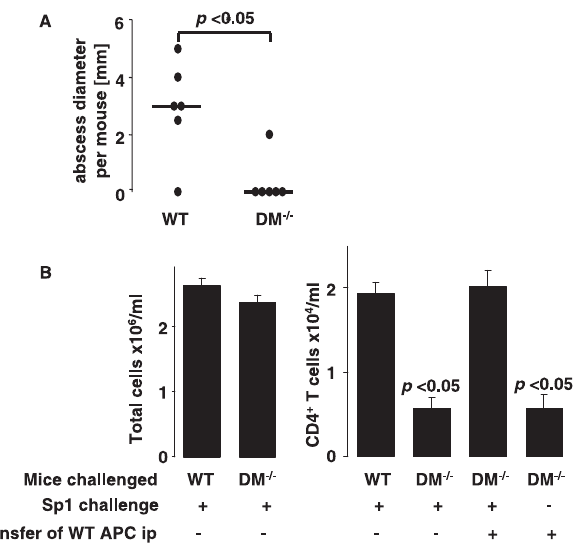
Figure 6. DM Dependency of Sp1-Mediated T Cell–Dependent Immune Responses (A) WT and DM (cid:3) / (cid:3) were challenged with Sp1 and intraperitoneal abscess formation was measured after 6 d. (B) The total cellular influx (left panel) and the influx of CD4 þ T cells (right panel) into the peritoneal cavity was evaluated in WT and of DM (cid:3) / (cid:3) mice 24 h after Sp1 challenge and/or adoptive transfer. doi:10.1371/journal.ppat.0030032.g006 PLoS Pathogens |